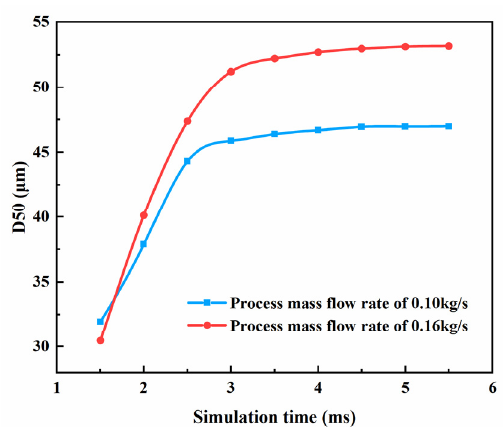
Figure 6. The time taken to reach a converged normalized average mean diameter when utilizing the KHRT breakup model.